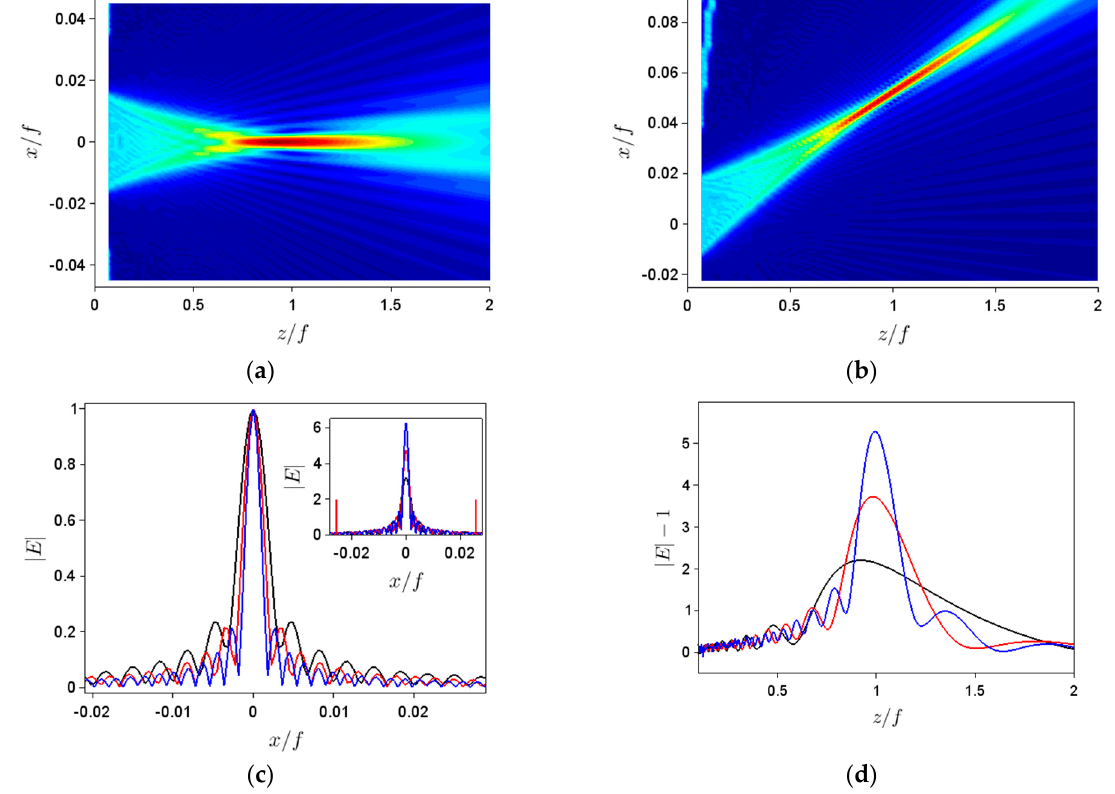
Figure 2. ( a , b ) Spatial dependences of the absolute values of diffracted electric fields in Figure 1b. Spatial distributions in the ( c ) transverse and ( d ) longitudinal planes of the absolute value of diffracted electric fields for ∆ φ m = 10°, f = 10 mm, and N /2 = 400 (black line), 600 (red line) and 800 (blue line). ( c ) Normalized field distributions; inset: not normalized. The vertical red lines in the inset show the extent of the region taken into account for higher-order moments calculation for N /2 = 600.